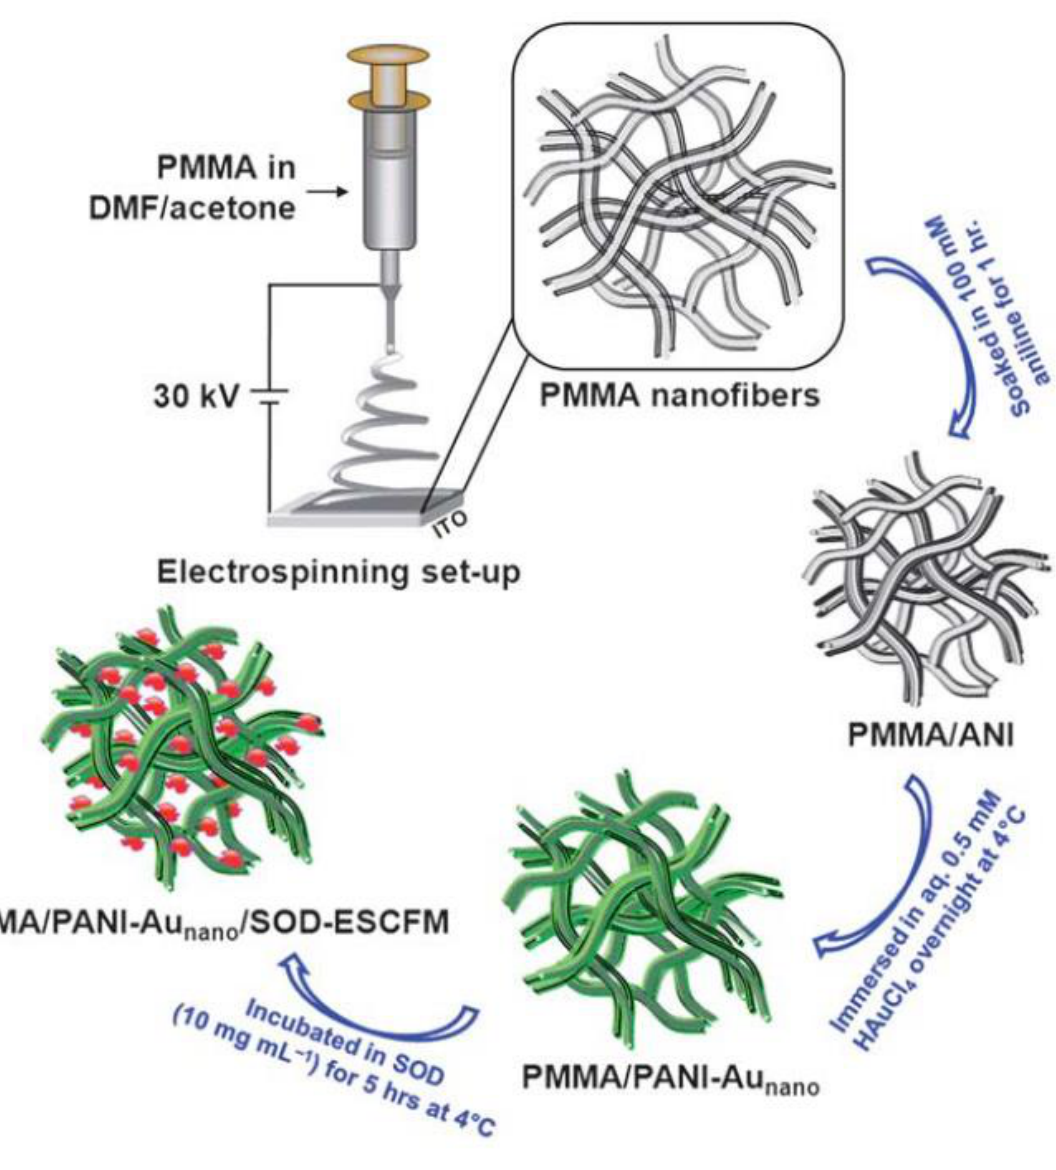
Figure 20. PMMA/PANI superoxide sensors were prepared by electrospinning PMMA and coating the resultant nanofibers with PANI via chemical oxidation of aniline with hydrogen tetrachloroau- rate [261]. The enzyme superoxide dismutase was then bonded to the gold nanoparticles formed in the PANI during oxidation, and the enzyme was used to detect superoxide. Republished with per- mission of Ref. [261]; permission conveyed through Copyright Clearance Center, Inc.